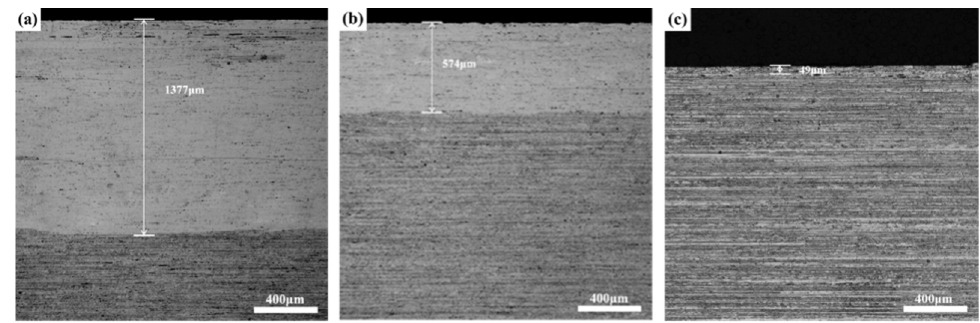
Figure 6. OM images of three different plate samples: ( a ) ASP sample; ( b ) DSP sample; ( c ) TDSP sample.